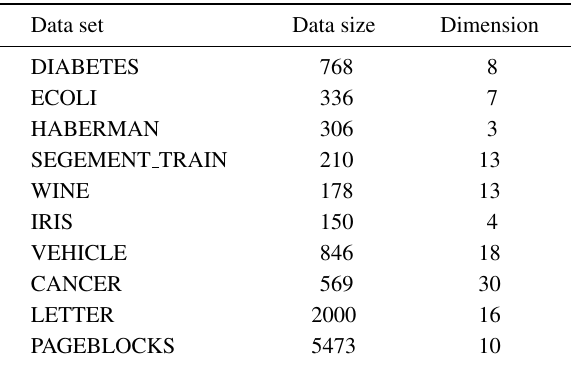
Table 1 UCI data sets.